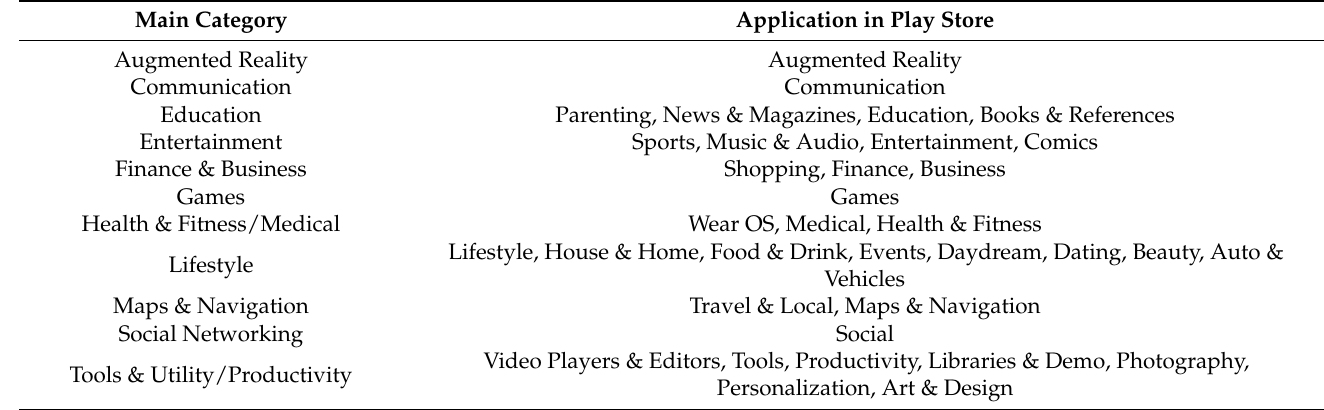
Table 7. Clustering of mobile applications into main